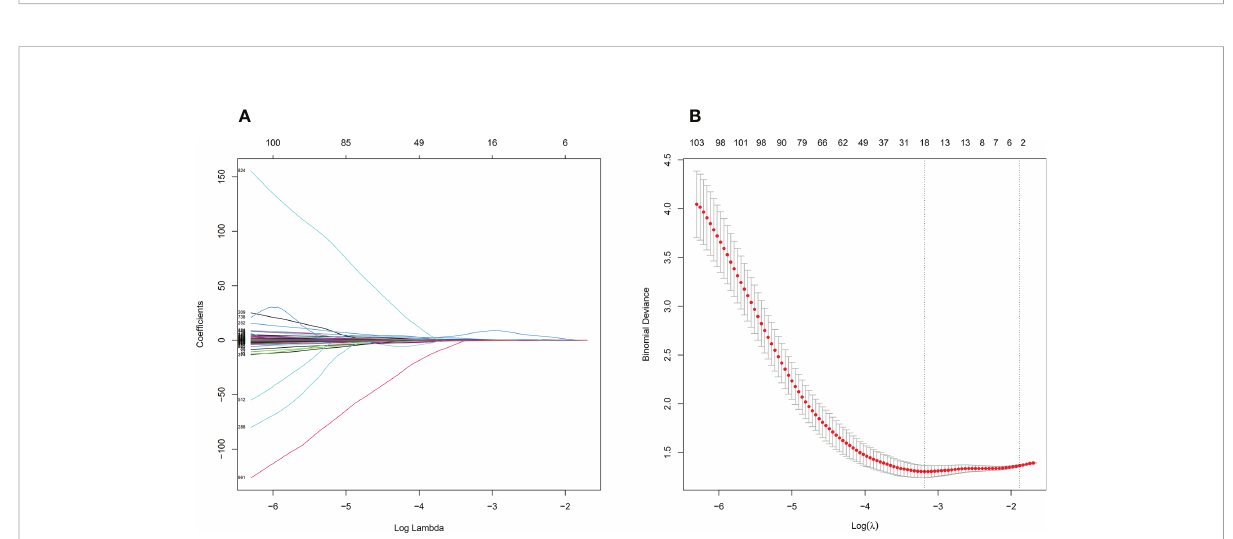
FIGURE 5 Feature selection process by LASSO in CECT. (A) shows the shrinkage diagram of 1227 radiomics features ’ coef fi cients from CECT. (B) shows the 10- fold cross-validation curve, 18 optimal features were chosen based on the lambda.min criteria. LASSO, least absolute shrinkage and selection